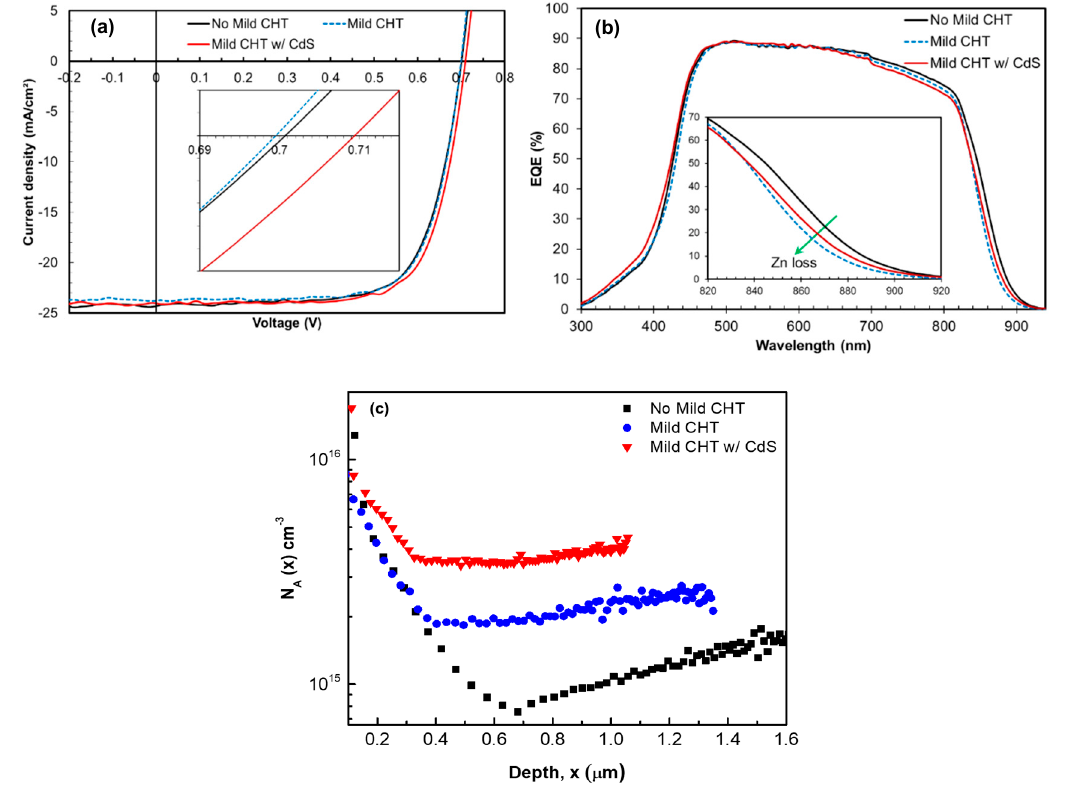
Figure 7. ( a ) Illuminated J-V curves ( b ) EQE spectra, and ( c ) acceptor concentration profiles of ZnTe:As back contacted devices: no mild treatment, with additional mild CHT (with and without CdS cap layer).